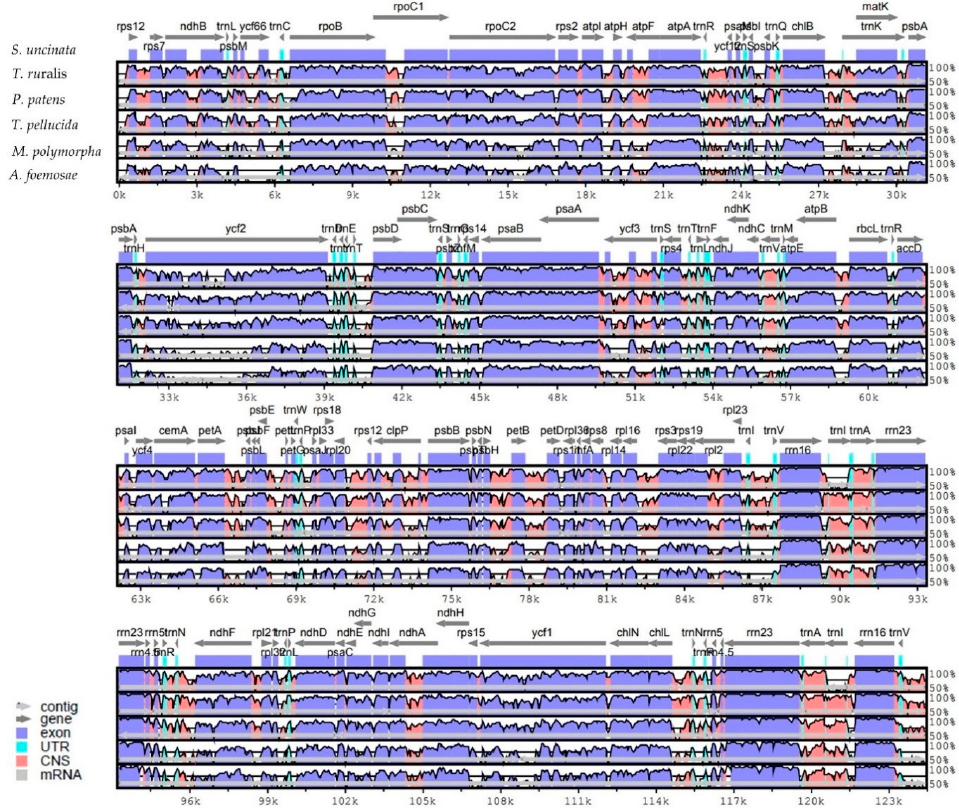
Figure 2. Alignment of complete plastome sequences from six species. Alignment and comparison were performed using mVISTA and the percentage of identity between the plastomes was visualized in the form of an mVISTA plot. The sequence similarity of the aligned regions between S. uncinata and other five species is shown as horizontal bars indicating average percent identity between 50–100% (shown on the y-axis of graph). The x-axis represents the coordinate in the plastome. Genome regions are color-coded for protein-coding (exon), rRNA, tRNA and conserved non-coding sequences (CNS) as the guide at the bottom-left.